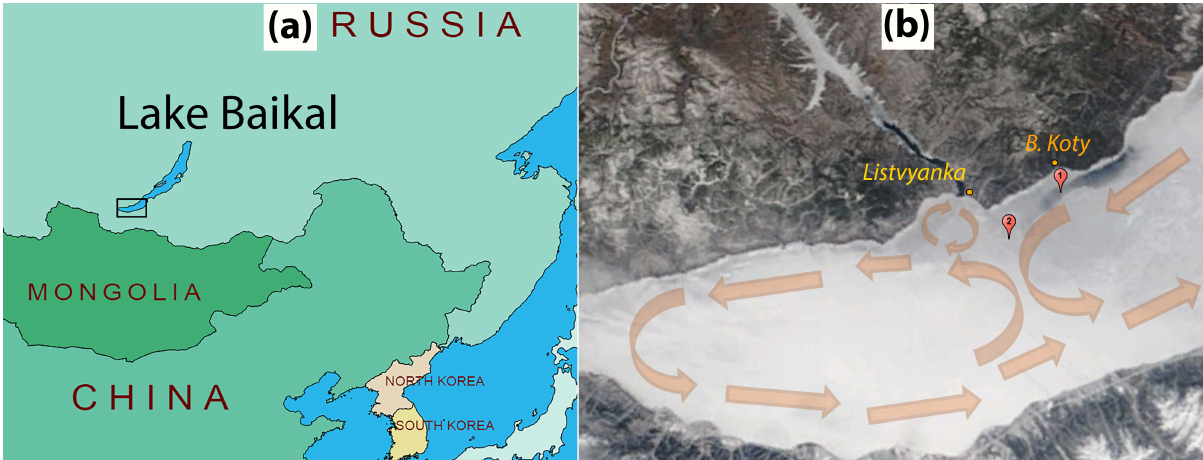
Figure 7. ( a ) Geographical location of the study site; ( b ) Ice conditions at the end of the experiment (on 31 March 2014) with the pattern of mean currents according to [34] in the southern part of Lake Baikal and locations of the autonomous measurement stations. The satellite image (Terra MODIS true color band composition) obtained from the Irkutsk Center of Remote Sensing [35]. Note the stronger ice melt in the area of the jet current around Station 1 visible as a dark area in Panel ( b